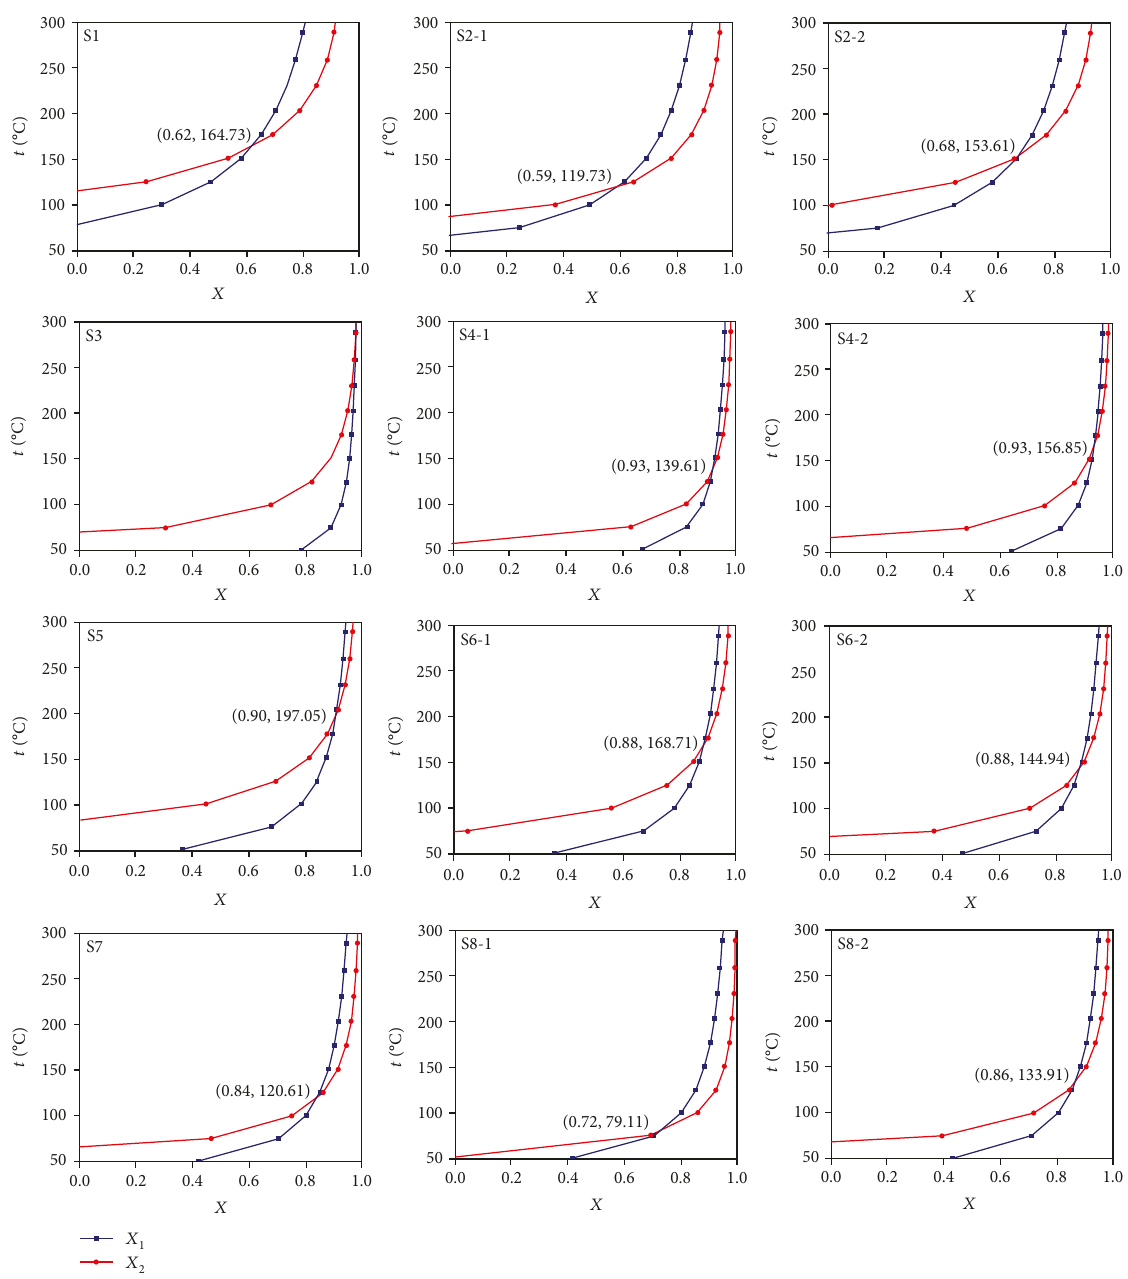
Figure 13: Diagram of temperature relative to proportion of cold water in the hot spring water samples in the Simao Basin ( X proportion of the cold water in mixing calculated by the enthalpy; X content of SiO 2